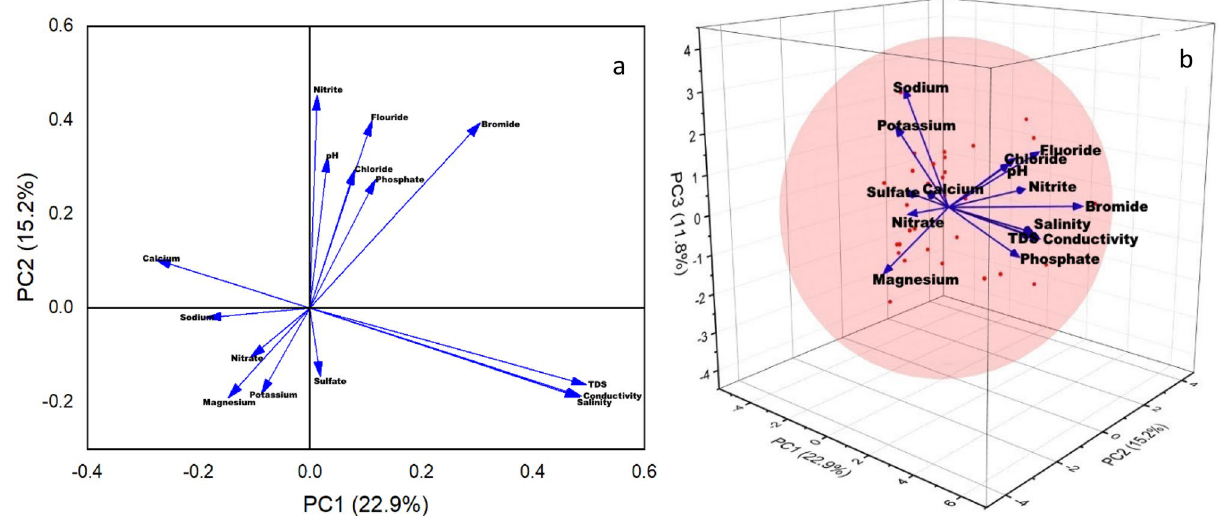
Figure 6. ( a ) 2D biplot (2PCs) and ( b ) 3D plot (3PCs) of principal